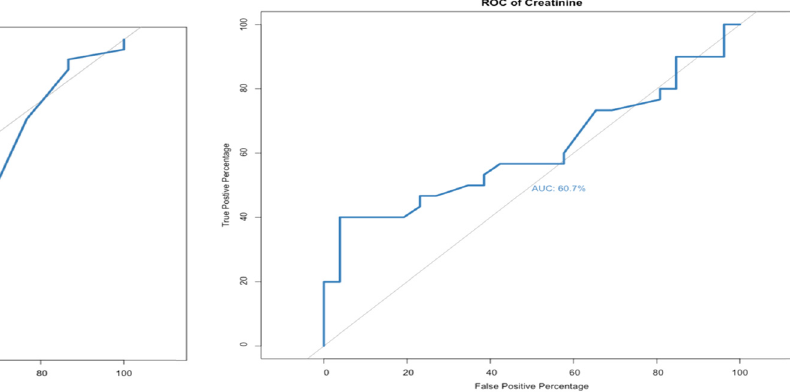
Figure 4: AUROC curve of change in creatinine level ( OR = 2.62, p - value = 0.0576, speci fi city = 96.2%, and sensitivity = 40.0% )